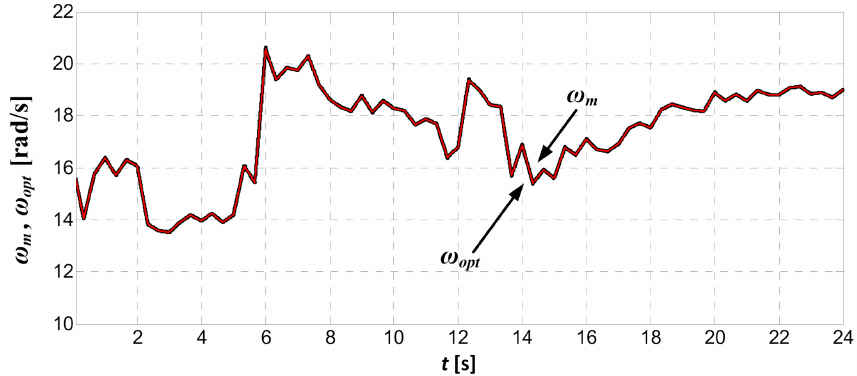
Figure 17. Waveforms of reference speed ω opt and the actual angular speed ω m of wind turbine and PMSG.